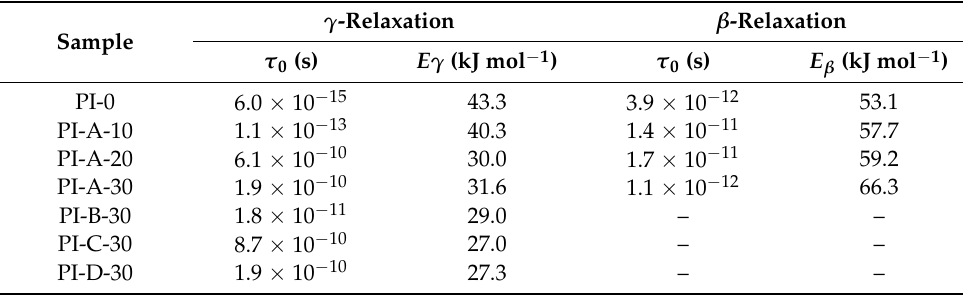
Figure 9. Arrhenius plots of γ - and β - relaxations. Table 5. The numerical values of Equation (3) for the samples.